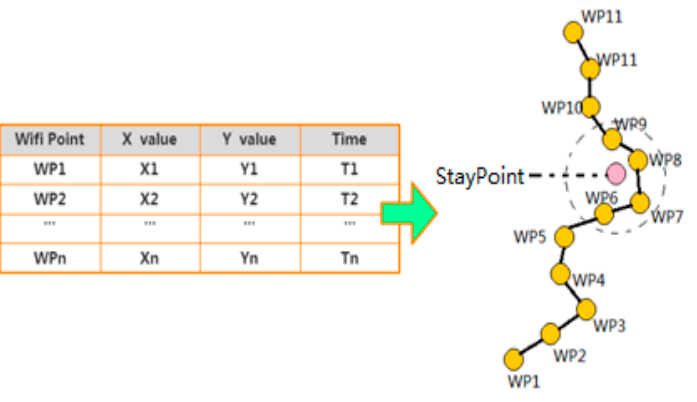
Figure 3. Wi-Fi Point (WP) and Wi-Fi Point Log (WPL).